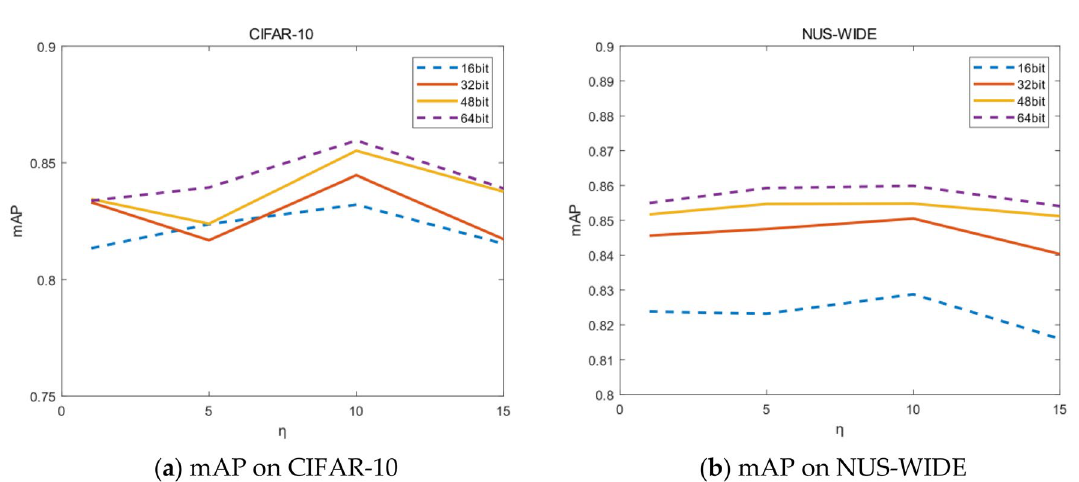
Figure 5. ( a,b ) Represent mAP on different ζ . (Created by “matlab R2019a” url: https:// ww2. mathw orks. cn/ produ cts/ matlab.